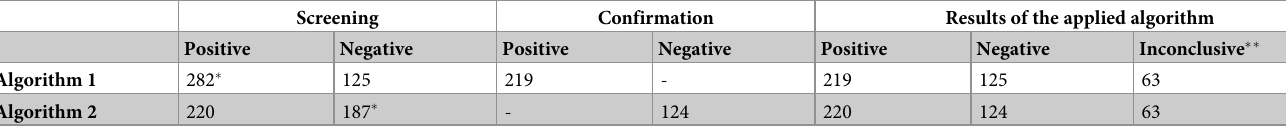
Table 4. Summary of the diagnostic performance of algorithm 1 and 2.